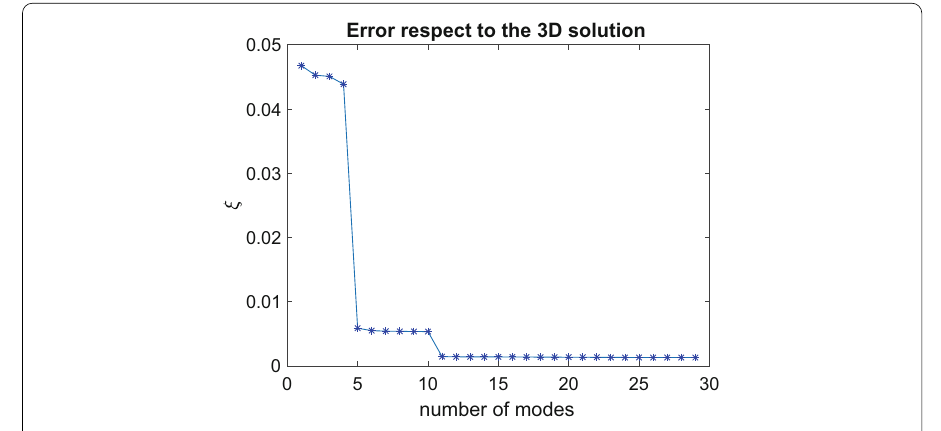
Fig. 11 Error of the enriched solution respect to the 3D solution for different number of